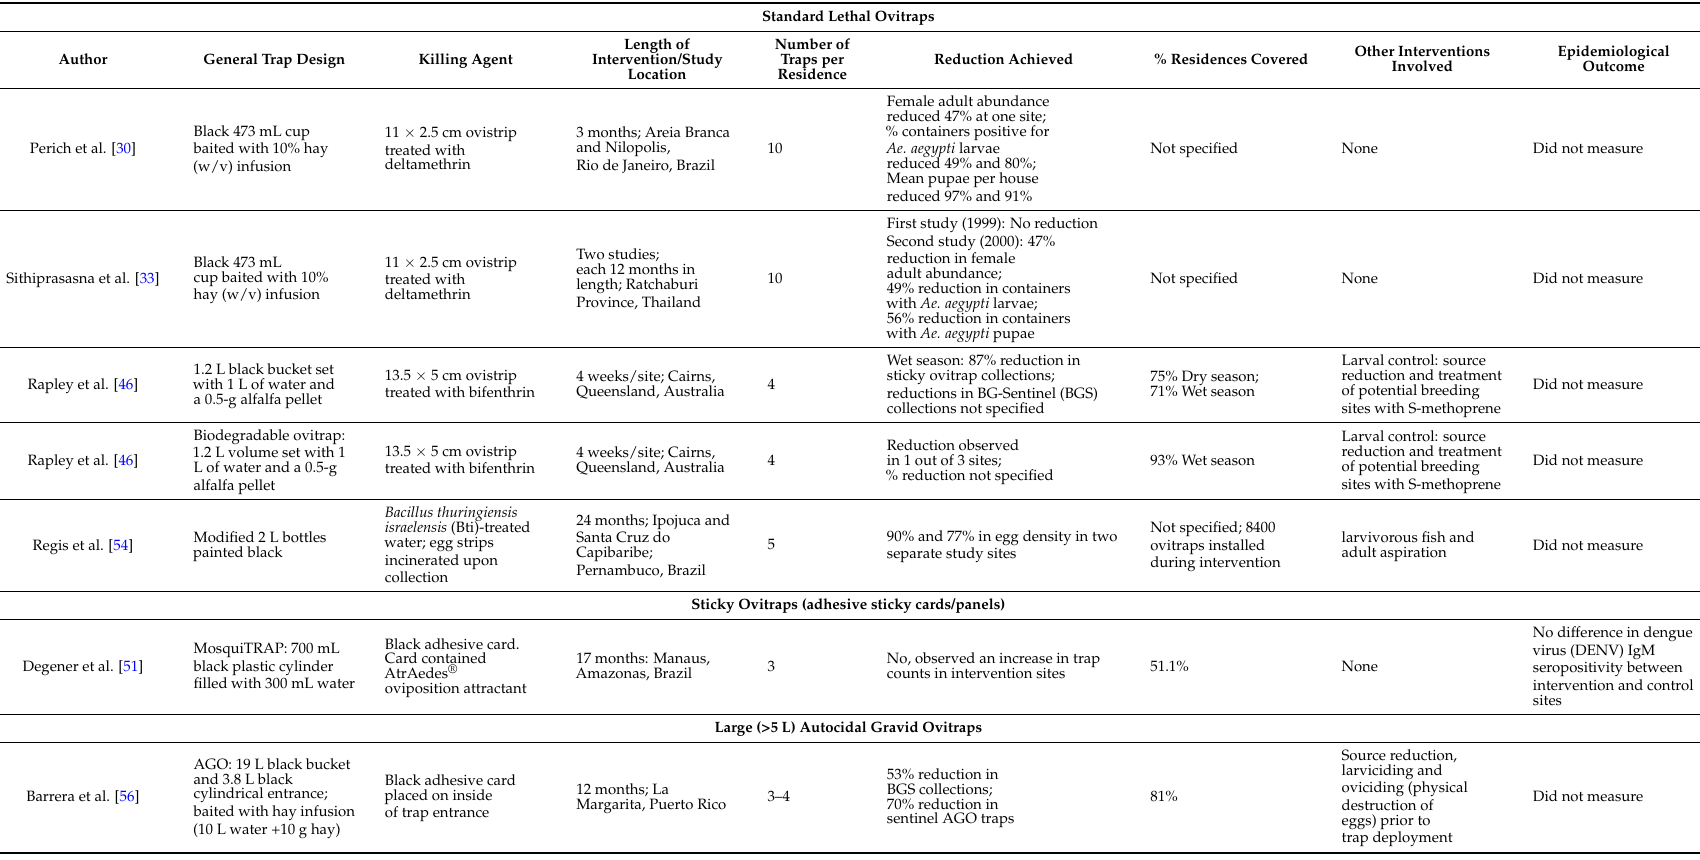
Table 1. Summary of lethal oviposition trap mass-trapping interventions to control female Aedes aegypti populations.